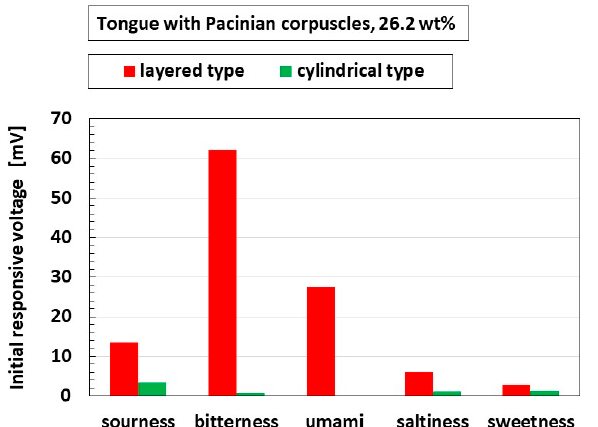
Figure 14. Comparison of initial response voltage between layered and cylindrical Pacinian corpuscles for five tastes.